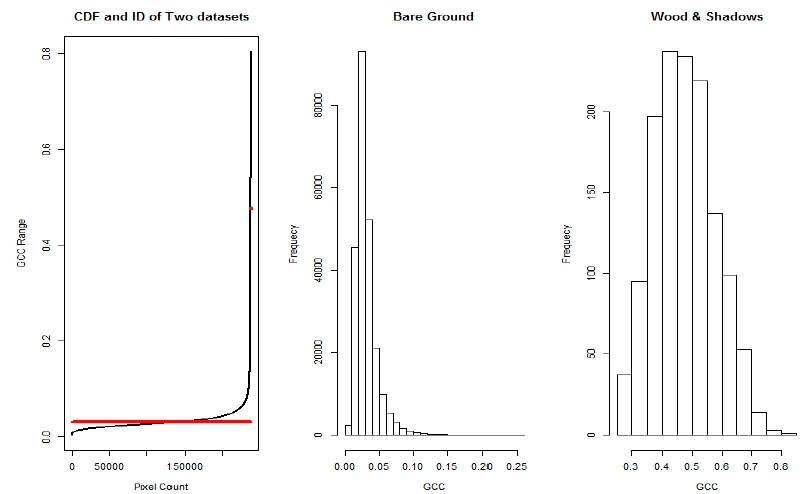
Figure A4. Cumulative distribution frequency (CDF) of data shown in Figure 9c, with histograms of the two ranges after splitting the original CDF.